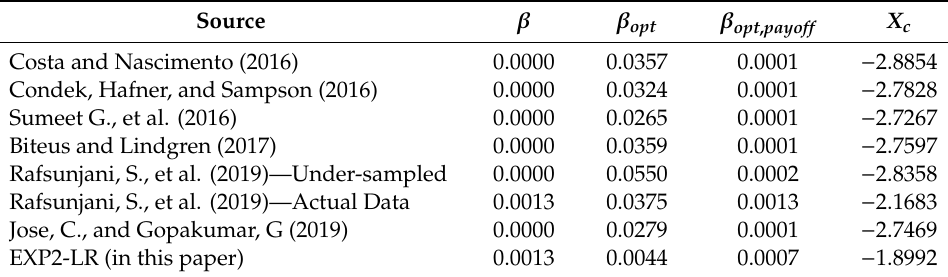
Table 8. Comparison of the proposed approach to methods reported in previous studies based on β values and X c over the test set.